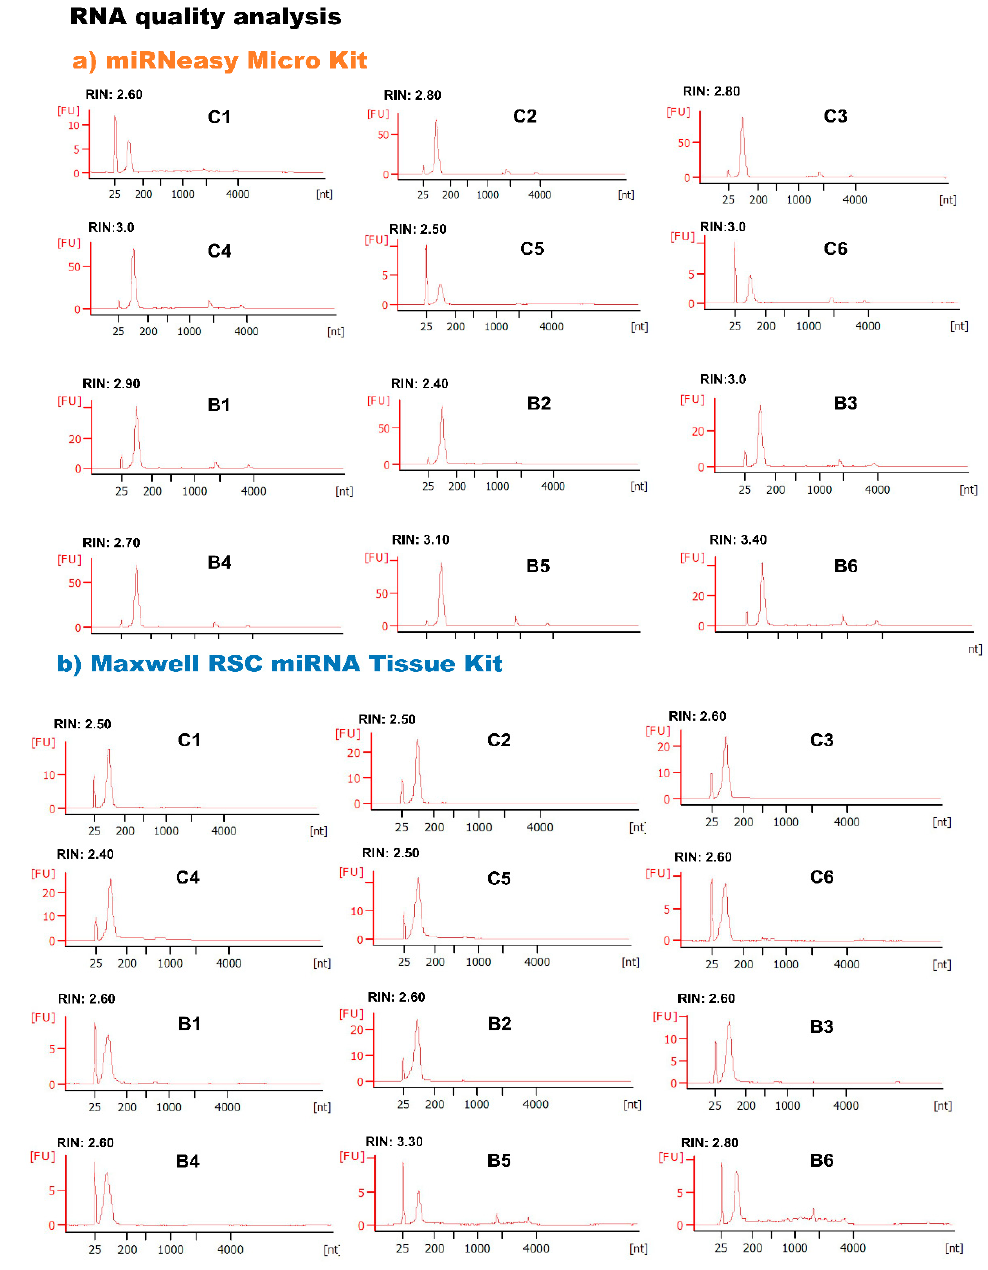
Figure 3. RNA quality analysis. The total RNA in bovine milk sEVs extracted by miRNeasy Micro Kit ( a ) and Maxwell RSC miRNA Tissue Kit ( b ) was analyzed for RNA quality assessment by using Total RNA Nano Kit (Agilent 2100 Bioanalyzer). The electropherograms demonstrated size distribution of nucleotides and fluorescence intensity value of total RNA in bovine milk sEVs. The peak at 25 nt indicated the internal standard. The 18s- and 28s-ribosomal RNA is a part of the mathematical algorithm where RIN values were calculated and being used as a measure of the RNA quality (RIN; 1 = totally degraded, 10 = intact). The RIN value from the extracted RNA was showing no 18s- and 28s-ribosomal RNA peaks. nt, nucleotides; FU, fluorescence intensity; RIN, RNA integrity number; c, uninfected control cattle; B, BLV-infected cattle.